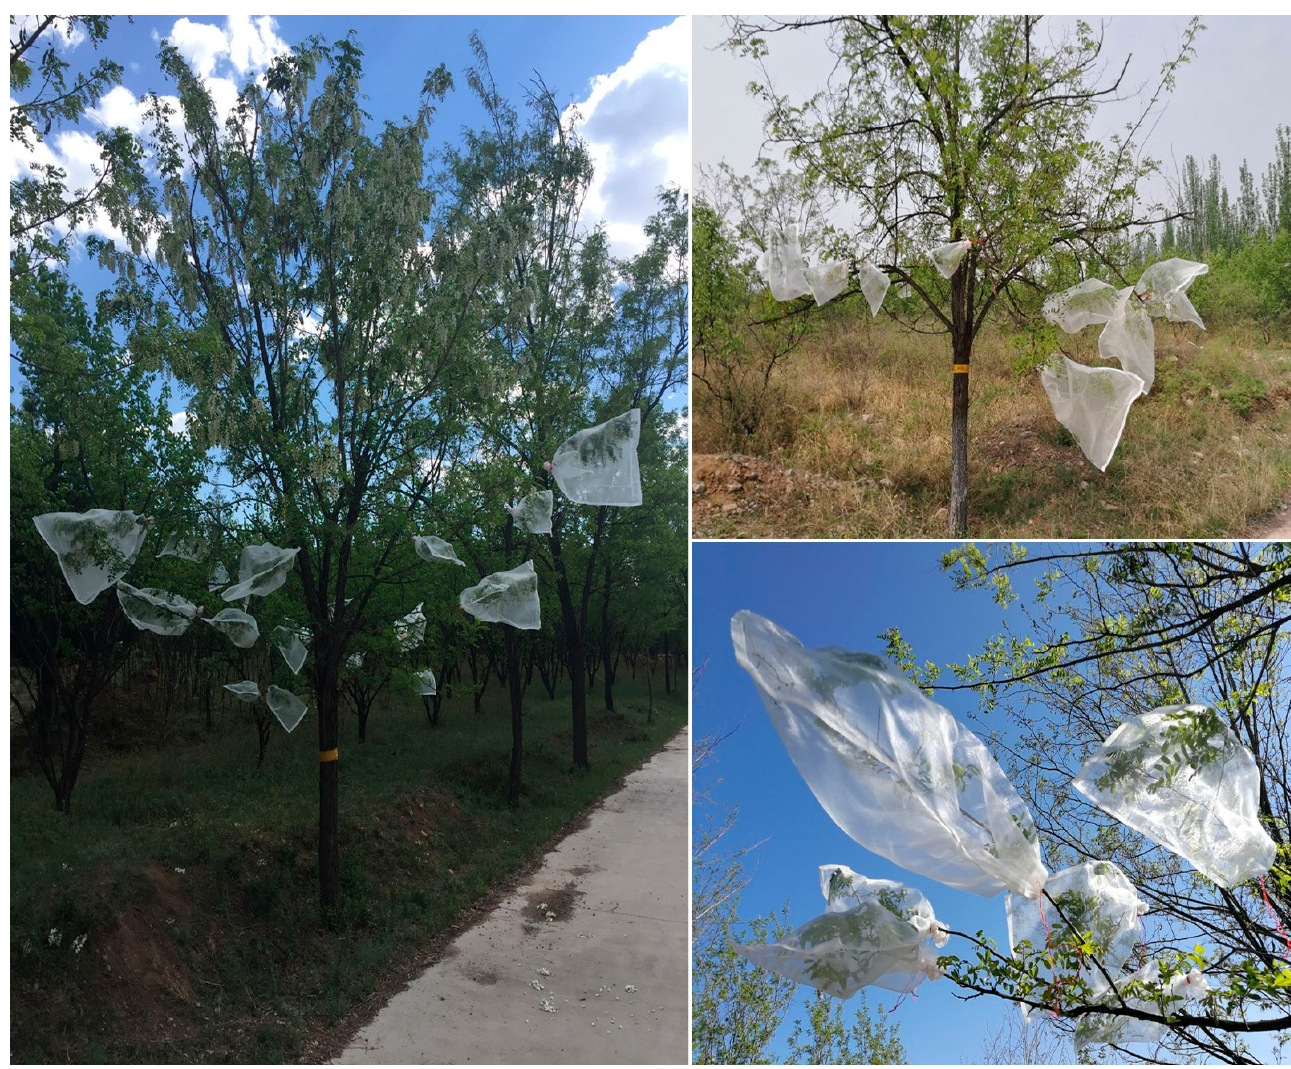
Figure 1. Maternal flowers were bagged without castration before flowering.